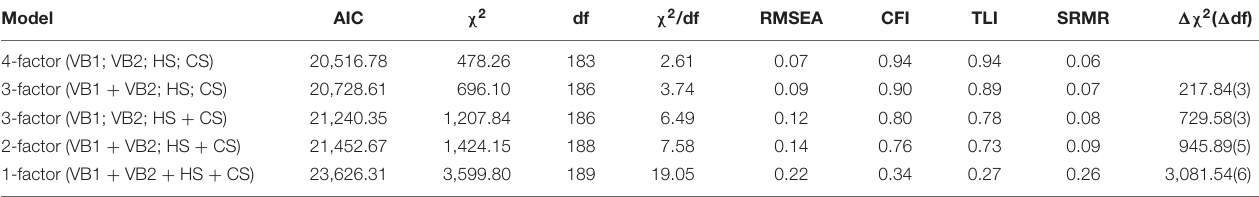
TABLE 1 | Confirmatory factor analysis.